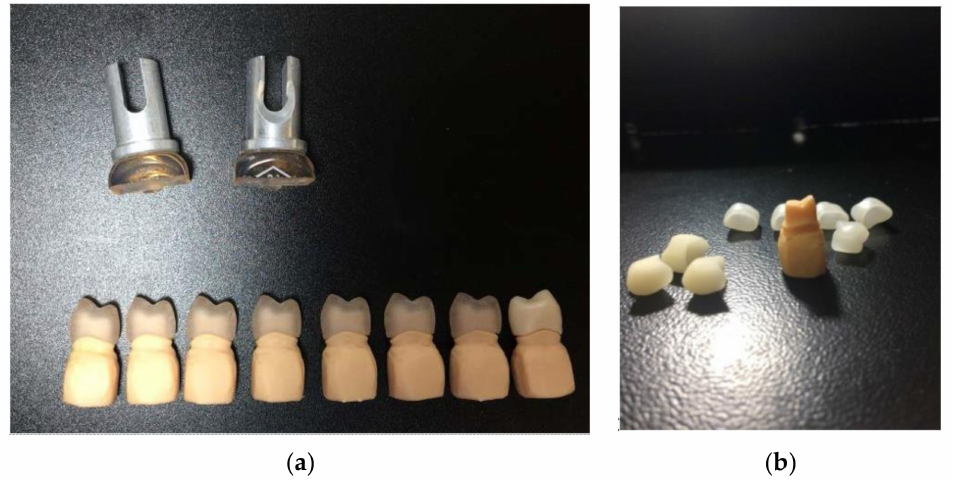
Figure 1. ( a ) Pre-crystalized ZLSM crowns (Vita Suprinity, Vita Zahnfabrick, Germany) and ( b ) 3D printed abutment and the milled wax